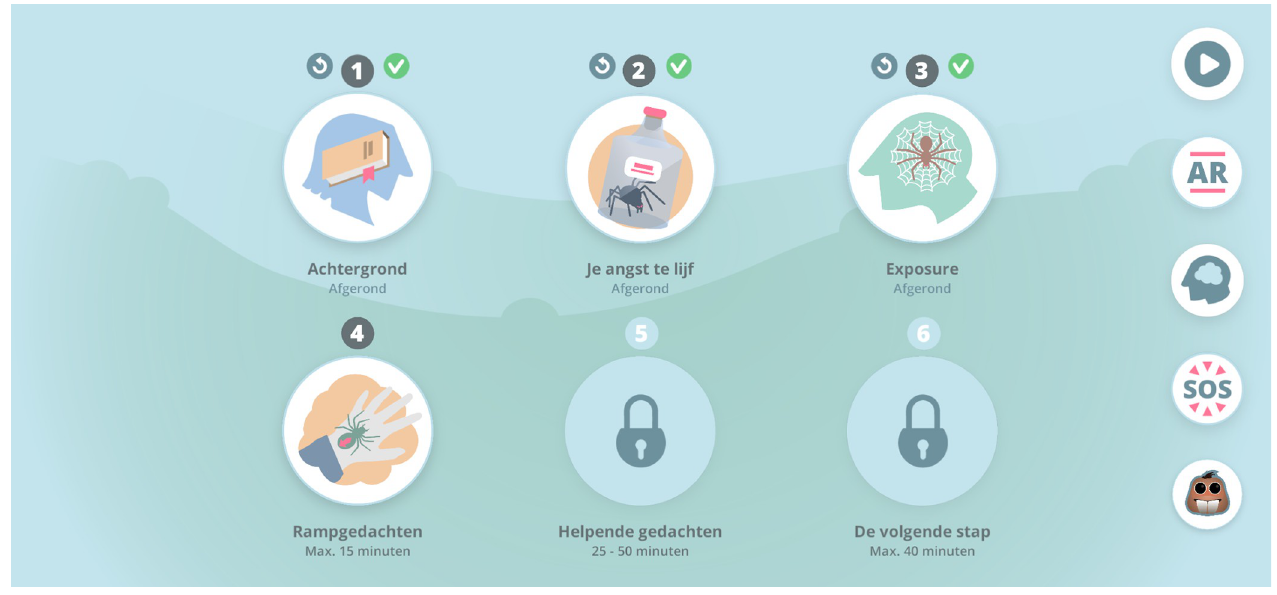
Fig 3. Home screen (see Table 1 for translations of the module’s